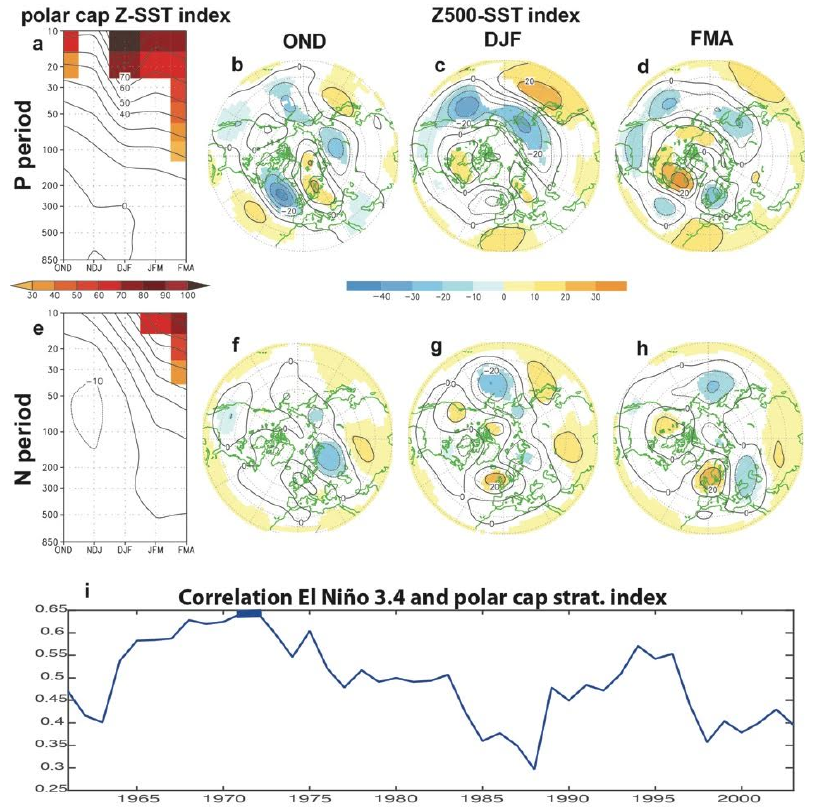
Figure 3. Analysis of the stratospheric pathway of ENSO-European weather teleconnection. ( a – d ) Regression maps of different anomalous 7-year high-pass filtered fields on the SST expansion coefficient of the first co-variability mode of the tropical SSTs and the European rainfall in FMA for the P period: ( a ) Area-averaged geopotential height over the polar cap (90°–60° N) in different months (from OND to FMA) (contour interval: 10 m); ( b – d ) Geopotential height at 500 hPa in OND, DJF and FMA, respectively (contour interval: 10 m); ( e – h ) Same as ( a – d ) but for the N period. Shadings correspond to statistically significant correlations between the SST index and the Z anomalies at a 95% confidence level (Monte-Carlo test with 400 permutations); ( i ) 20-year centered moving correlation windows between the 7-year high-pass filtered geopotential anomalies at 10 hPa and averaged over the polar cap (90°N–60°N) in DJF and the 7-year high-pass filtered SST anomalies over the El Niño 3.4 area in the same months. Thick line indicates statistically significant values at a 90% confidence level (Monte-Carlo test with 400 permutations).